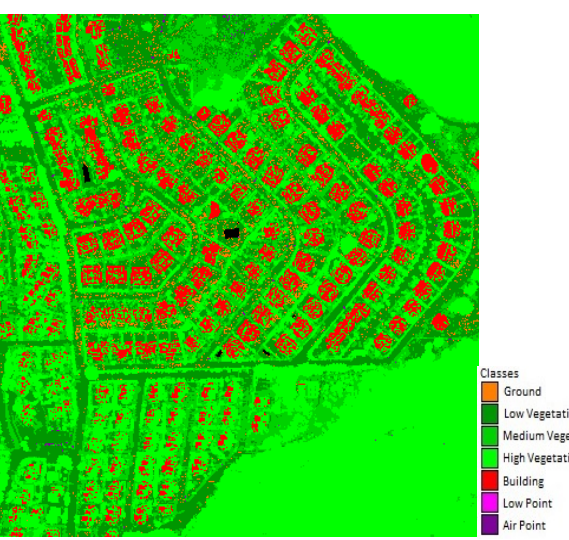
Figure 5. The roughly classified points cloud of the test area with standard parameters.